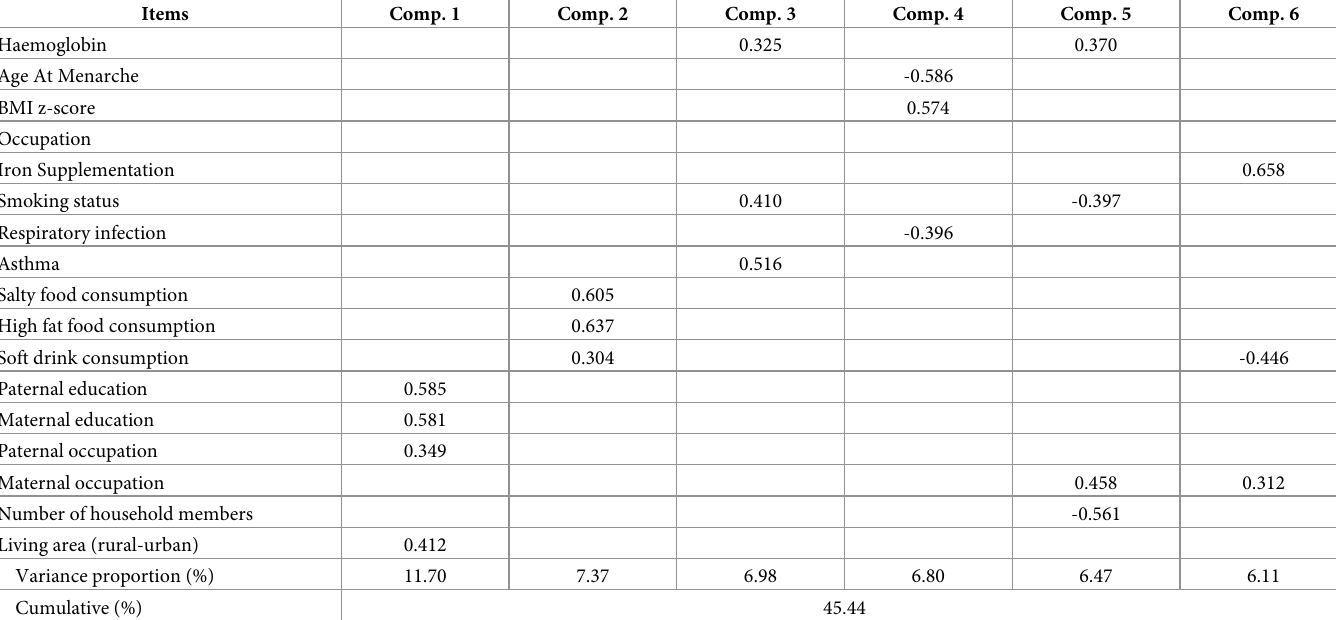
Table 2. Results of PCA of selected characteristics among Indonesian girls aged 15–19 years old (Riskesdas